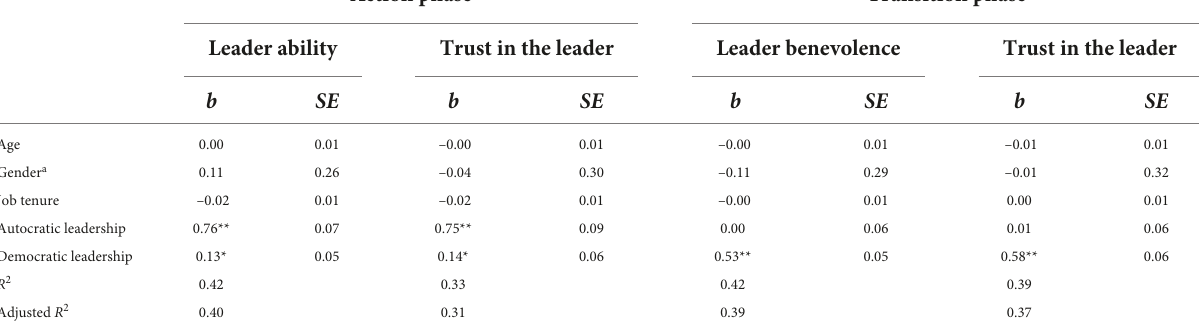
TABLE 6 Effects of leadership behaviors on trust in the leader and leader ability and benevolence (Study 2). Action